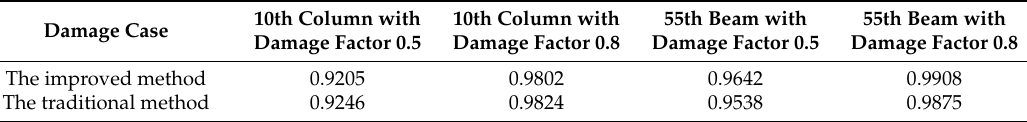
Table 6. Damage identification results of 2nd substructure with single column/beam